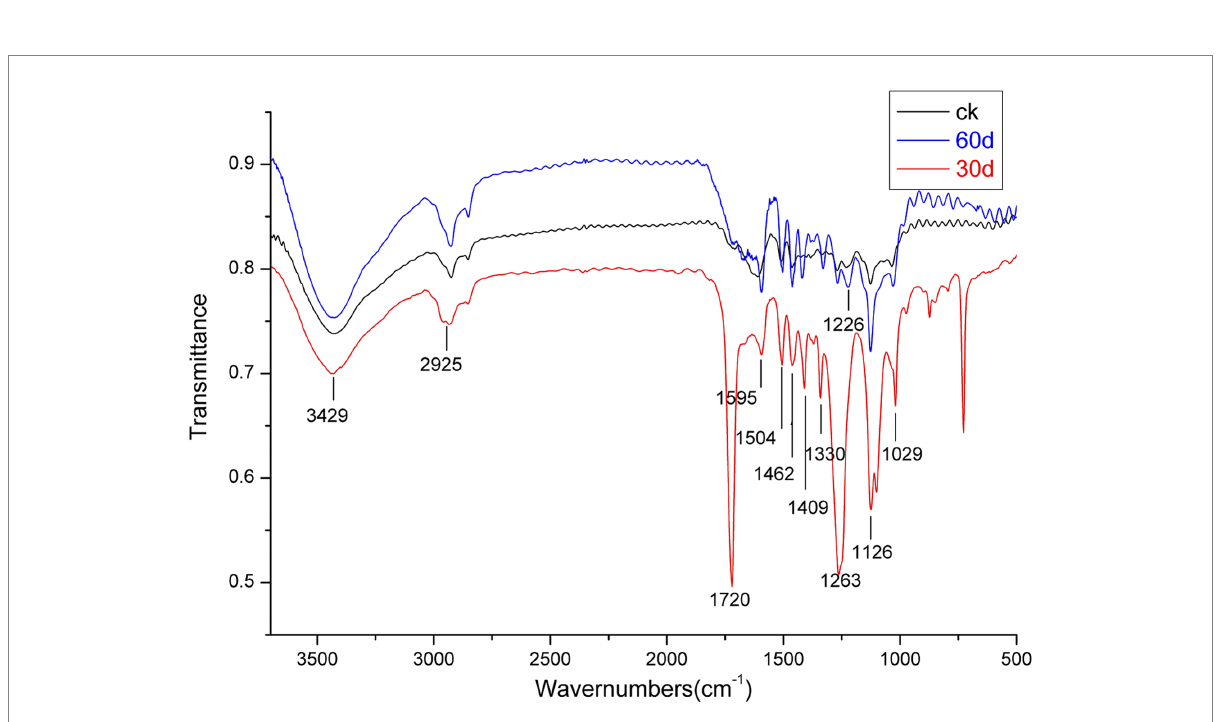
FIGURE 4 Infrared spectroscopy of milled wood lignin (MWL) from the cotton stalks pretreated by Suping 1 strain at various stages. ck stands for uninoculated cotton stalks medium; the red line represents 30 days pretreatment of cotton stalks medium; the blue line represents 60 days pretreatment of cotton stalks